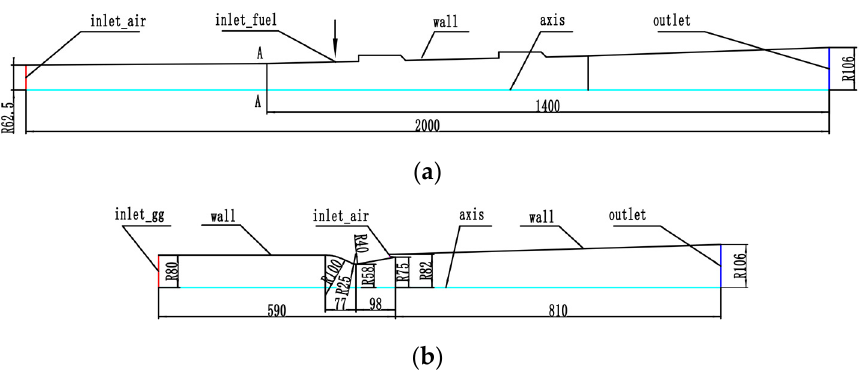
Figure 2. Geometric model of ( a ) the scramjet [28] and ( b ) the DCR (unit: mm).